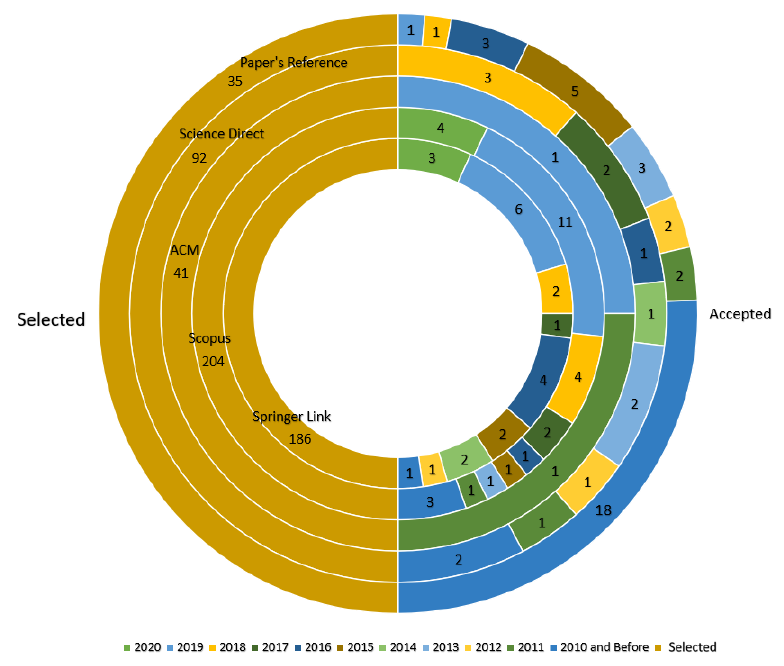
Figure 3. Distribution of publication per year and